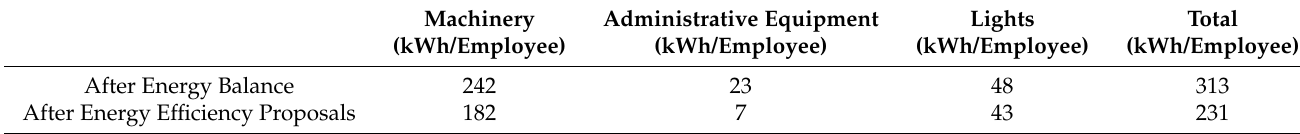
Table 7. Energy performance indicator.